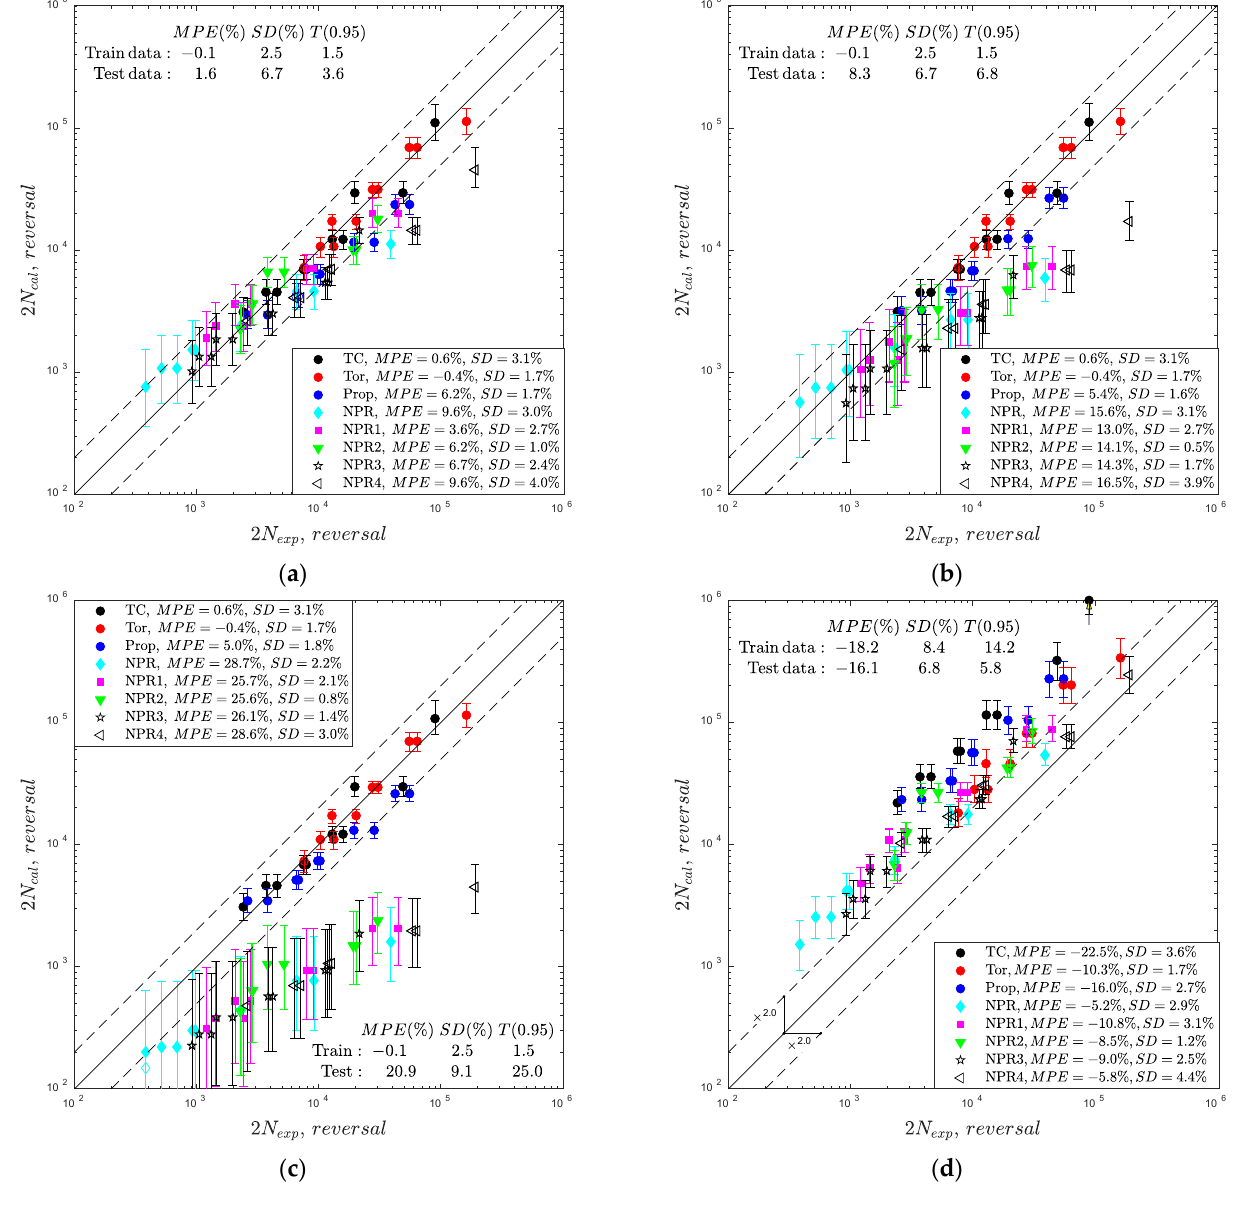
Figure 3. Comparison of experimental and calculated fatigue lives for the models of ( a ) Fatemi–Socie, ( b ) Brown–Miller, ( c ) Glinka et al., and ( d ) Yu et al.